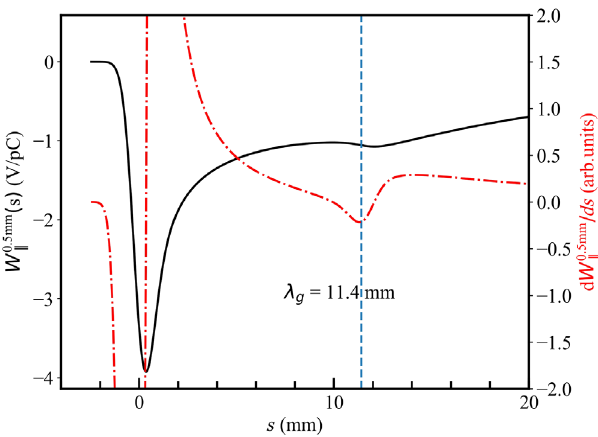
FIG. 2. The rf cavity wake potential (solid black line), its derivative (dash-dotted red line, right axis), and the s position which corresponds to the λ parameter (dashed blue g